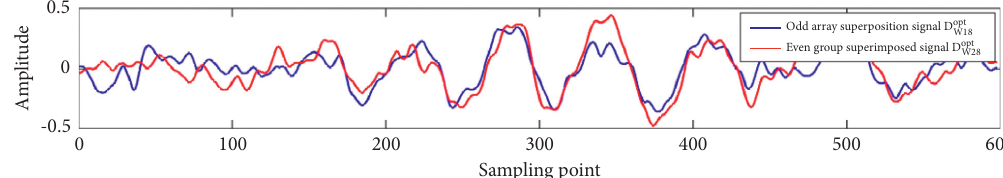
Figure 21: Odd group and even group superposition signals after 6-time